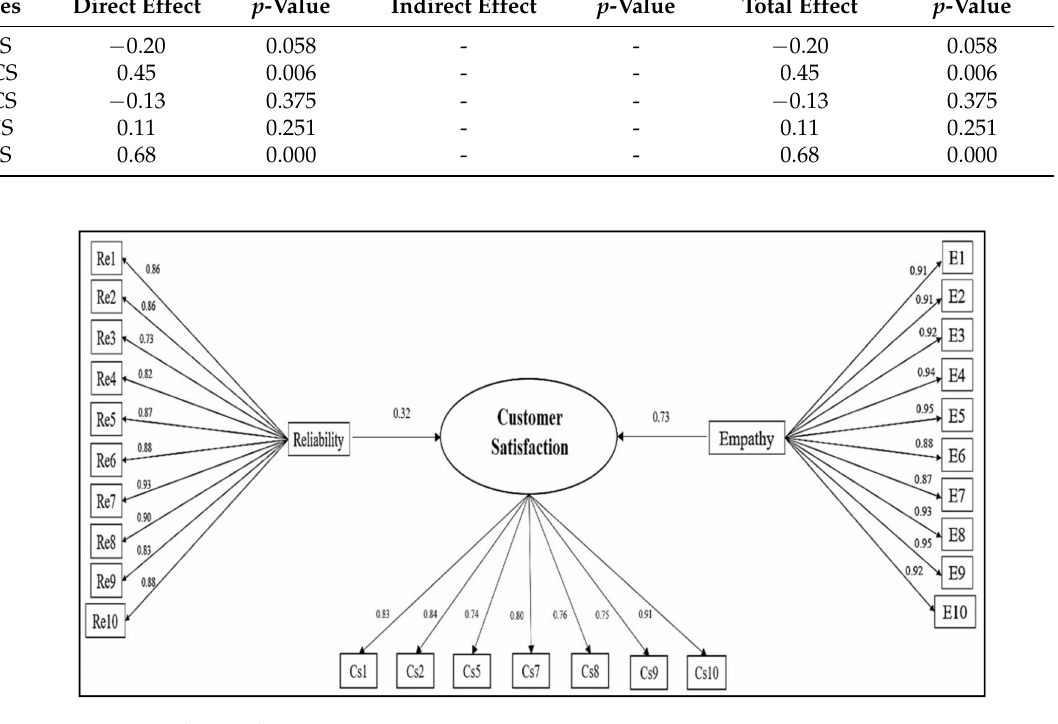
Figure 3. The Final SEM. Table 3. Construct Reliability and Validity.